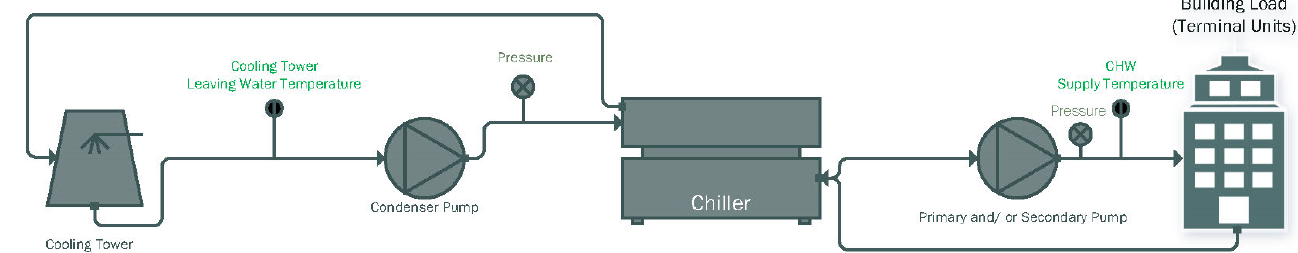
Figure 1. CWS schematic.